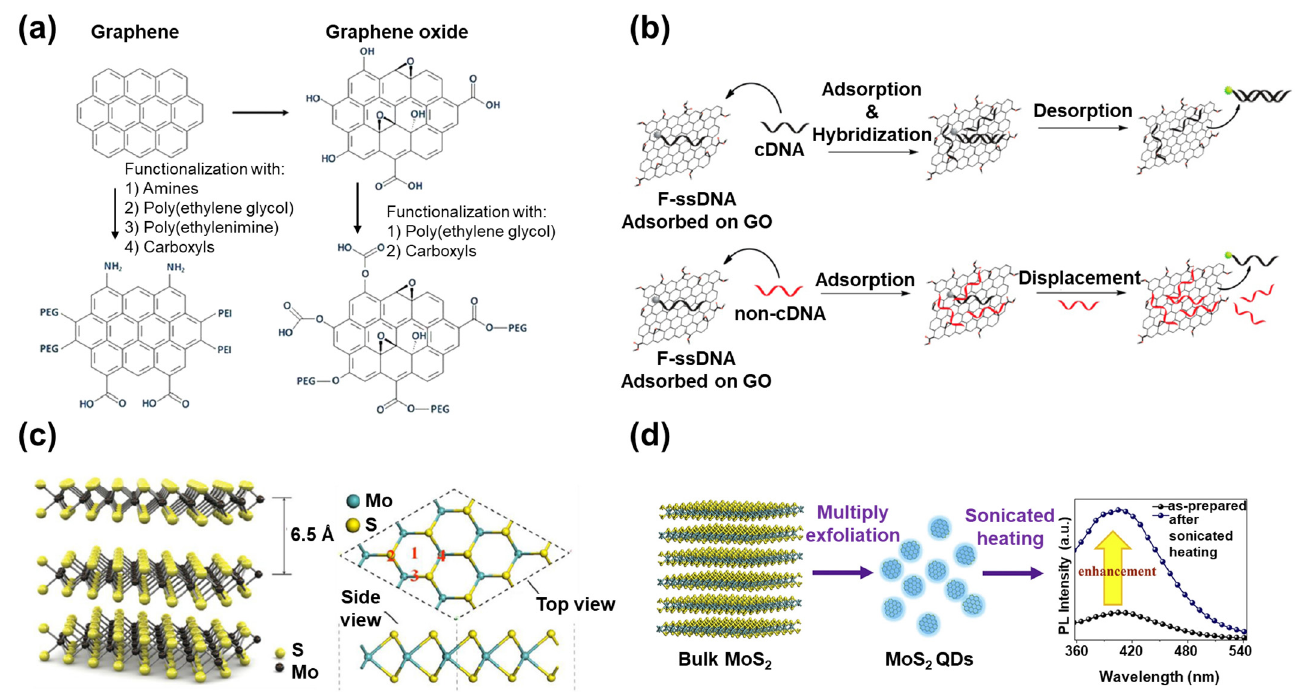
Figure 2. ( a ) Schematic of graphene and graphene oxide (GO) with various chemical property modification methods (reproduced with permission from [43], published by Elsevier, 2013), ( b ) the desorption of DNA from GO either via hybridization with cDNA on the surface of the GO or by nonspecific simple displacement by non-cDNA (reproduced with permission from [47], published by the American Chemical Society, 2014), ( c ) the detailed atomic structure of a MoS 2 nanosheet (reproduced with permission from [66], published by Elsevier, 2016), and ( d ) the synthesis process of the MoS 2 QD to improve the photoluminescence property (reproduced with permission from [69], published by Elsevier,